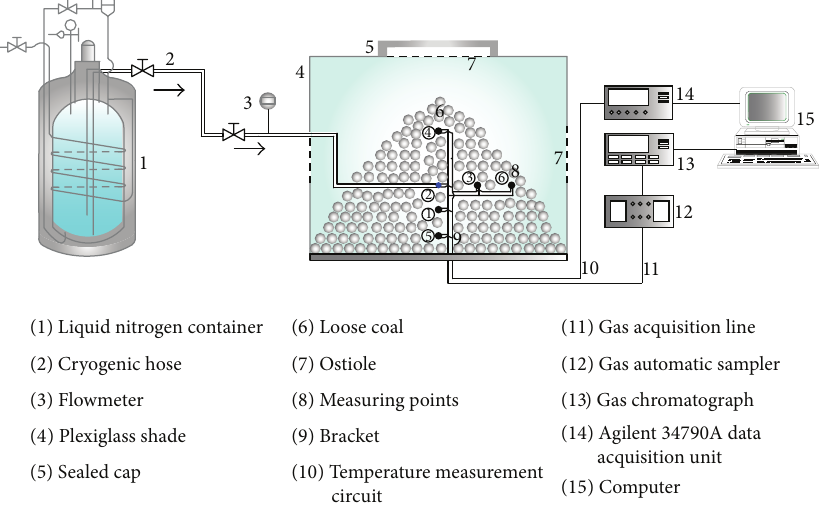
Figure 1: Experimental setup of heat and mass transfer of liquid nitrogen in porous